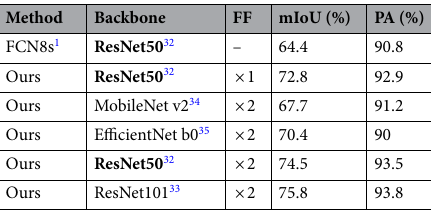
Table 1. Results of ablation experiments.